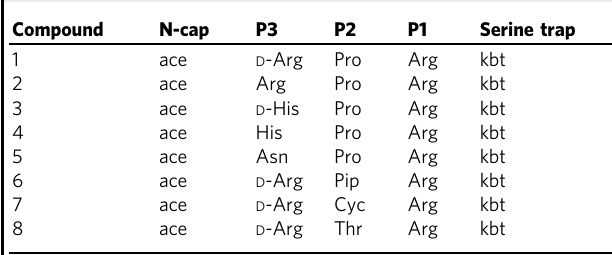
Fig. 1 Predicted binding of reference binder. a Docking of ace- D -Arg-Pro-Arg-aldehyde reference binder to matriptase surrogate model (white carbon atoms and surface). For a clear view, only residues forming polar interactions (yellow dashed lines), and the catalytic residues Ser-195 and His-57 are depicted. b Docking of ace- D -Arg-Pro-Arg-aldehyde reference binder to hepsin-based TMPRSS2 homology model (white carbon atoms and surface). For a clear view, only residues forming polar interactions (yellow dashed lines) and the catalytic residues Ser-186 and His-41 are depicted. c Docking of ace- D - Arg-Pro-Arg-aldehyde reference binder to TMPRSS2 crystal structure (PDB-ID: 7MEQ, white carbon atoms and surface). For a clear view, only residues forming polar interactions (yellow dashed lines), and the catalytic residues Ser-441 and His-296 are depicted. For all panels, carbon atoms of docked ligands are shown in green, oxygen in red, and nitrogen in blue. The distance between the nucleophilic serine oxygen and the electrophilic carbon atom of the serine trap in angstrom is illustrated by a dashed blue line. Table 1 Assembled peptidomimetic inhibitor library selected for